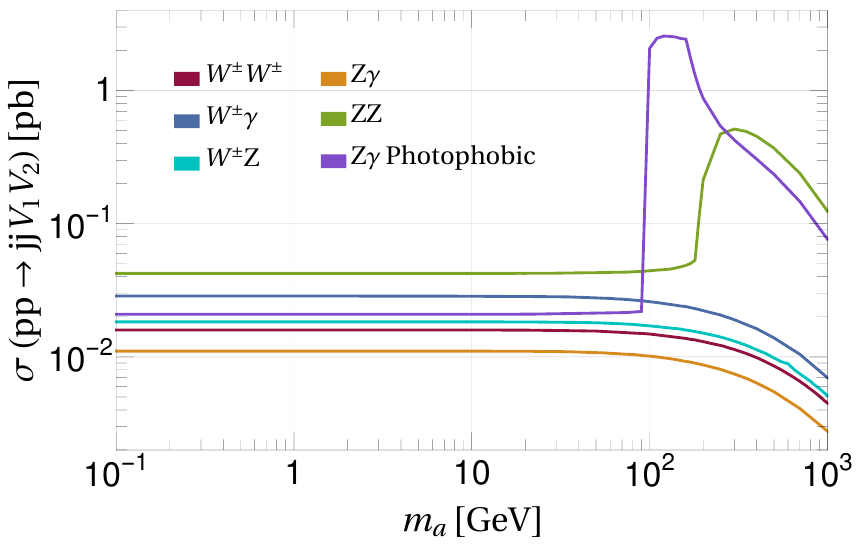
√ Figure 5 . Total cross sections at s = 13 TeV for the ALP contributions to the different VBS channels as a function of the ALP mass. All lines are evaluated at c corresponds to the benchmark point p 0 in eq. (4.2). The exception is the “ Zγ photophobic” case, that is evaluated at p 4 instead. At each point in the plot, the ALP decay width was re-computed as a function of m a , c and c e W e B